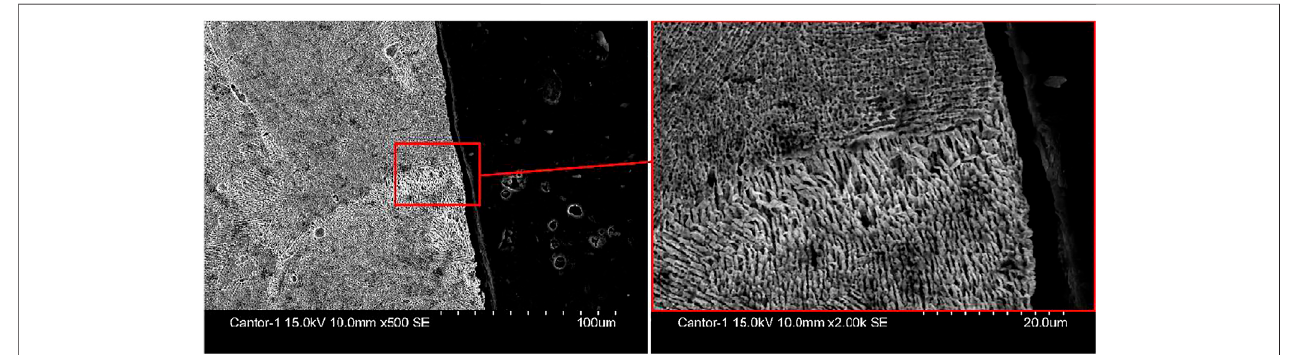
FIGURE 10 | Melt pool interface defect on SEM images of the 3D-printed Cantor alloy (185 W; 1,000 mm/s).